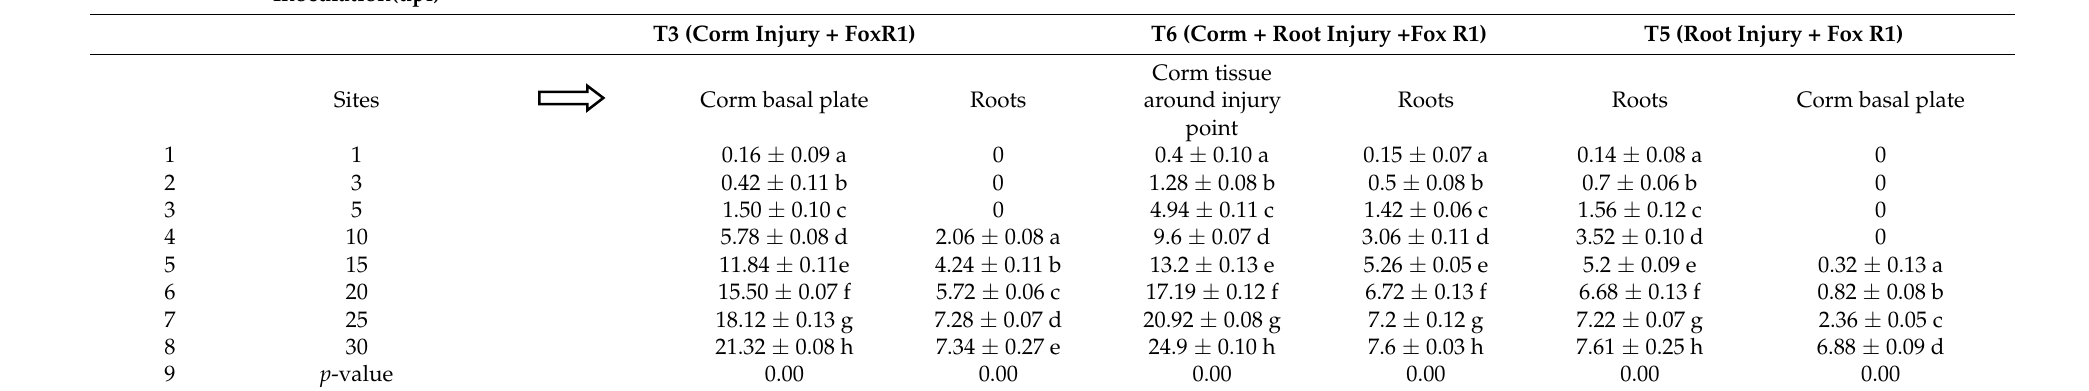
Table 5. In planta quantification of Fusarium oxysporum R1 load in different treatments by CFU method. S.No.